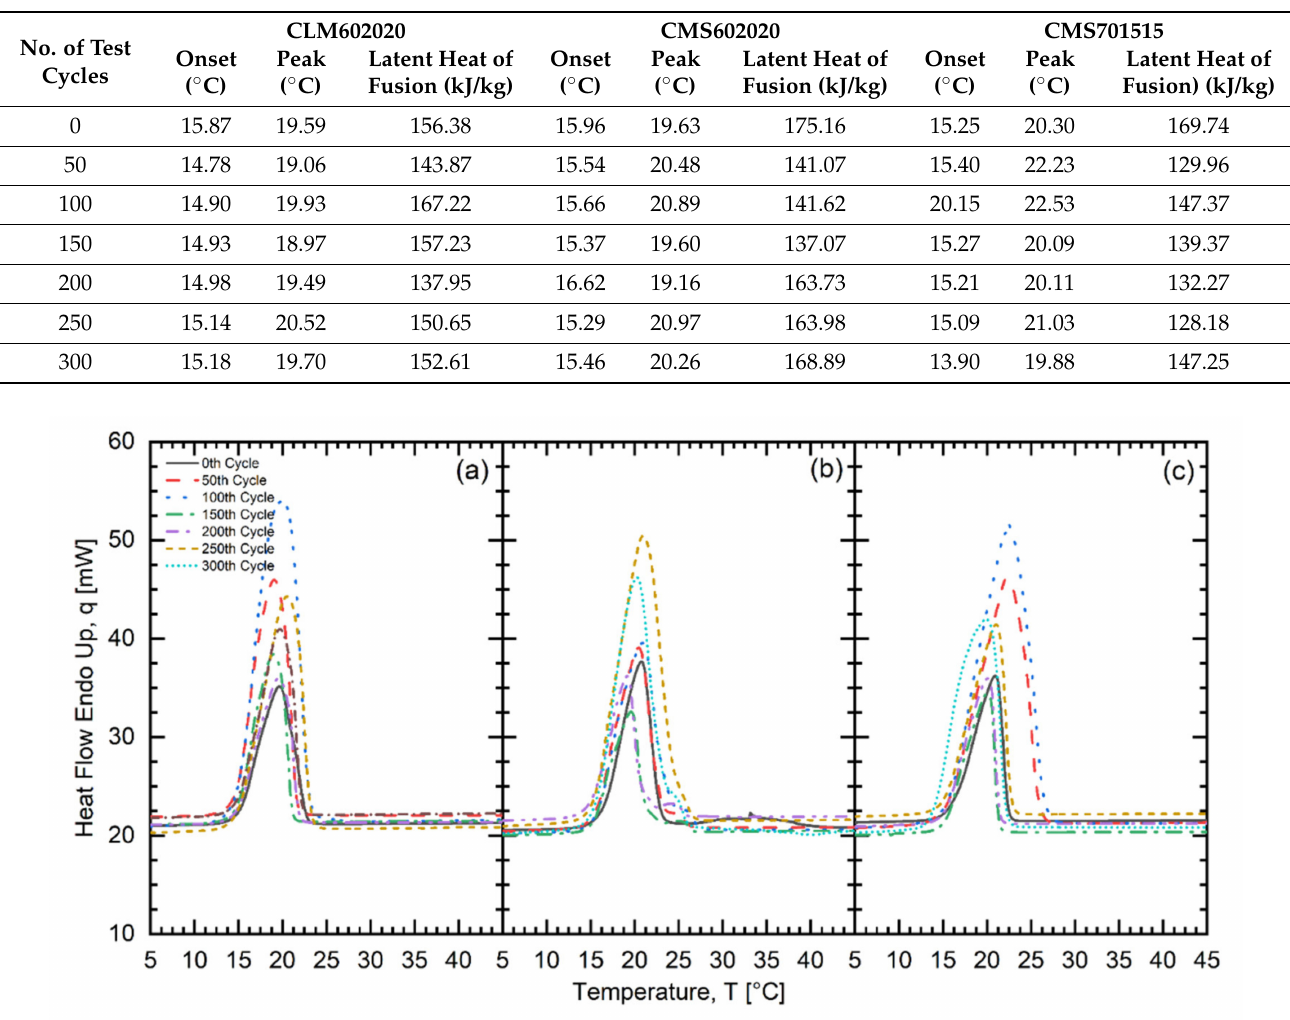
Figure 4. Cycle testing ( a ) CLM602020 ( b ) CMS602020 ( c )